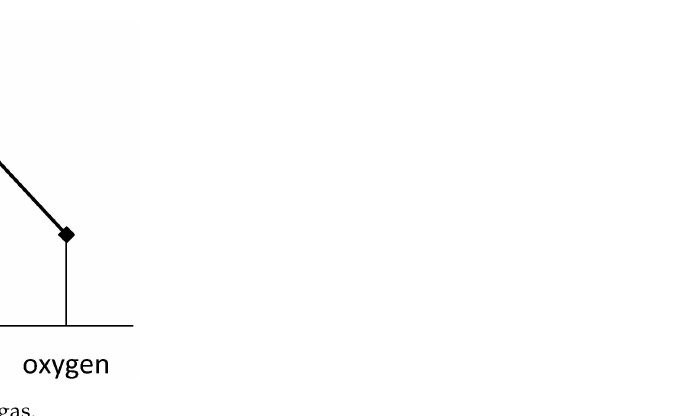
Figure 6. Effect of source gas.